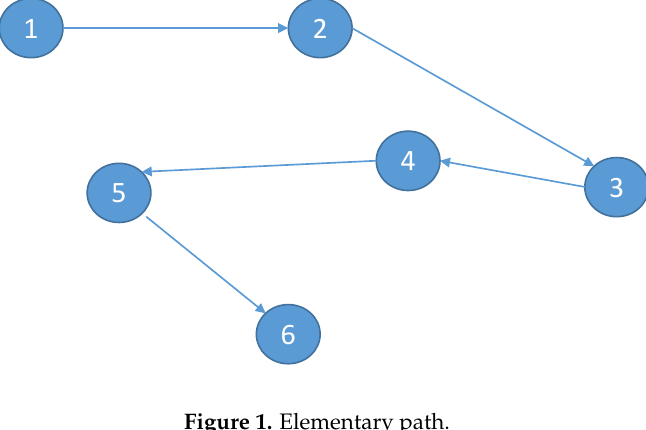
Figure 1. Elementary path.